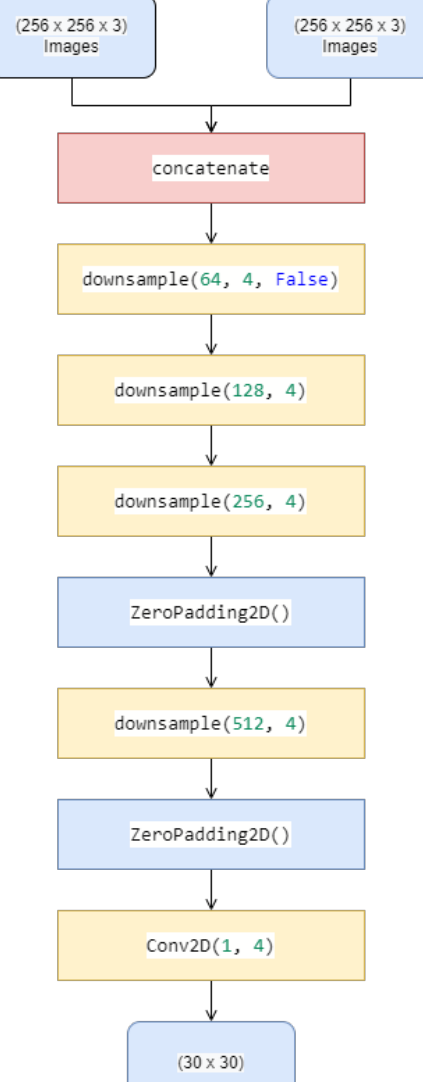
Figure 2. PatchGAN architecture used as the discriminator.